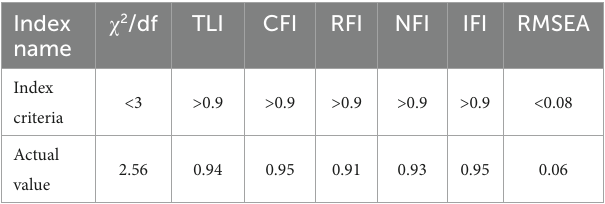
TABLE 3 Validity factor analysis model fit.